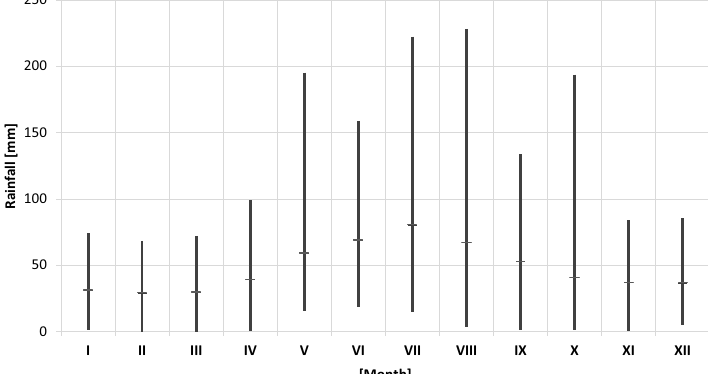
fig. 4. Distribution of maximum, average and minimum monthly precipitation totals in the 1951–2020 period at the iMGW station in Puławy.